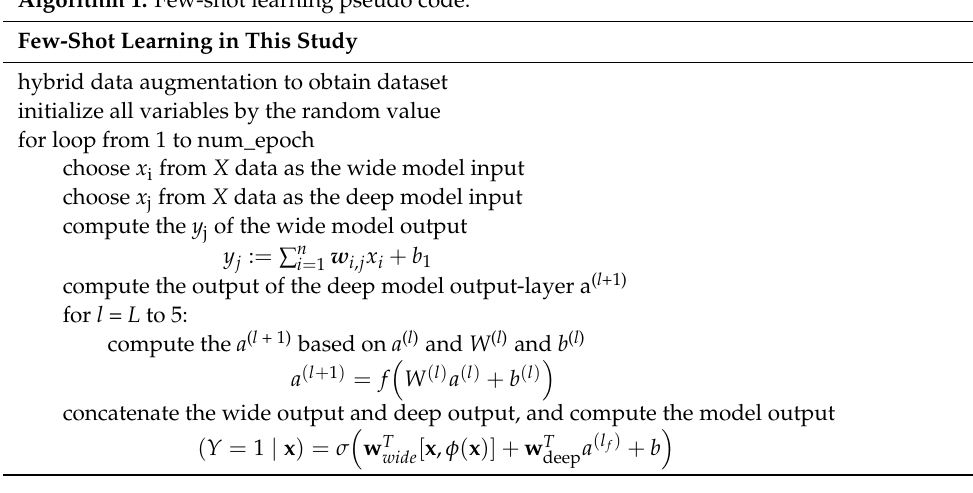
Algorithm 1. Few-shot learning pseudo